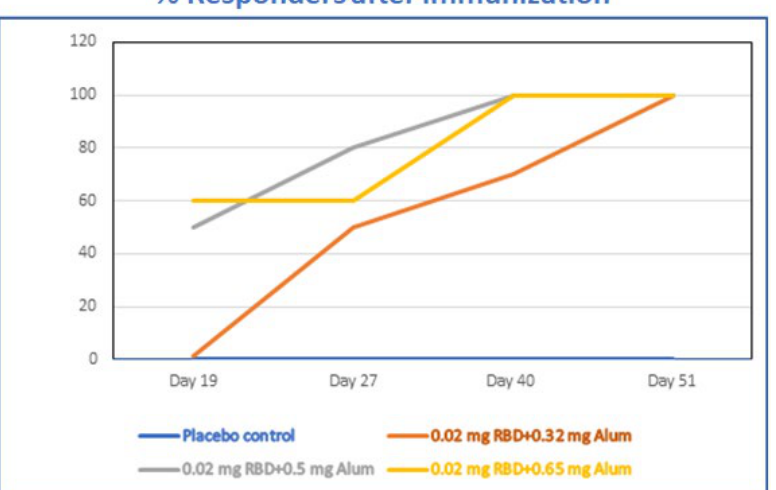
Figure 6. Precent BALB/c mice that developed measurable serum antibody responses against C1- RBD-C-tag antigen. The reciprocal end-point titers of anti-RBD-C-tag immunoglobulin antibody in sera from BALB/c mice immunized subcutaneously with 20 µ g RBD-C-tag antigen per mouse, adjuvanted with either 320 µ g, 500 µ g, or 650 µ g Alhydrogel ® ‘85’ representing Alhydrogel ® ‘85’/RBD- C-tag, adjuvant:antigen ratios of 16:1, 25:1 and 32:1 ( w / w ), respectively were measured. Titer values determined for peripheral blood sera collected at days 19, 27, 40 and 51. The percentage of mice that developed measurable serum antibody responses against C1-RBD-C-tag antigen was calculated. At day 19, no measurable titers for mice immunized with 20 µ g RBD-C-tag antigen adjuvanted with 320 µ g Alum, 50% responders for 500 µ g Alum adjuvanted and 60% responders for 650 µ g Alum adjuvanted were determined. At day 27, 50% of the mice that were immunized with 20 µ g RBD-C-tag antigen adjuvanted with 320 µ g Alum developed measurable titers, 80% of the mice that were immunized with for 500 µ g Alum adjuvanted and 60% responders for 650 µ g Alum adjuvanted were determined. At day 40, 70% of the mice that were immunized with 20 µ g RBD-C-tag antigen adjuvanted with 320 µ g Alum developed measurable titers, 100% of the mice that were immunized with for 500 µ g Alum adjuvanted and 100% responders for 650 µ g Alum adjuvanted were determined. At day 51 after Prime, Boost, Boost, 100% of mice immunized developed measurable serum antibody responses against C1-RBD-C-tag